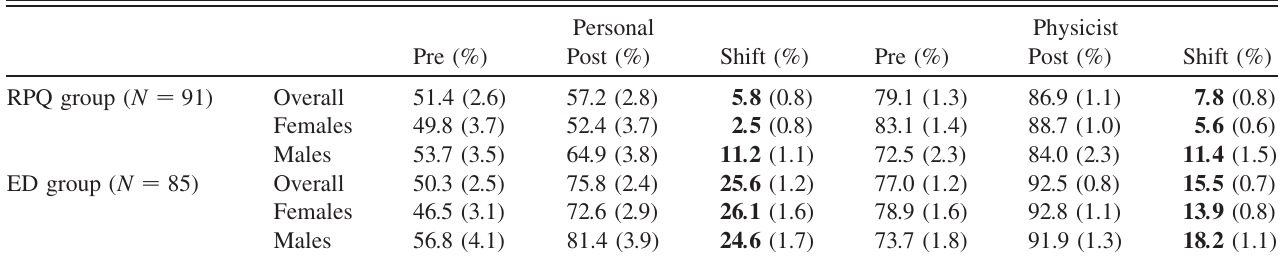
EFFECTS OF TWO DIFFERENT TYPES OF . . TABLE IV. Overall favorable scores on pre-CLASS and post-CLASS test for RPQ and ED group [standard error in parentheses; large shifts ( p < 0 : 05 ) in bold font]. Personal Physicist